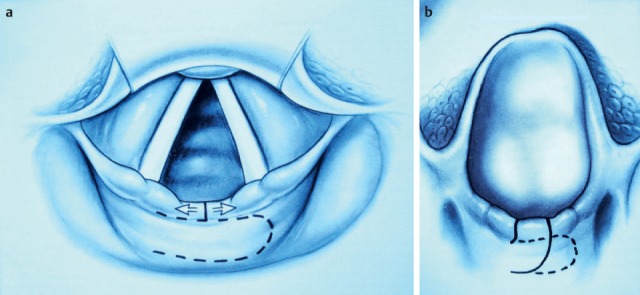
a – a low interarytenoid region may cause passage of saliva into the larynx, small transposition flaps are a therapeutic option; b – large transposition flap from the postcricoid region in order to establish the protection wall at the interarytenoid region.